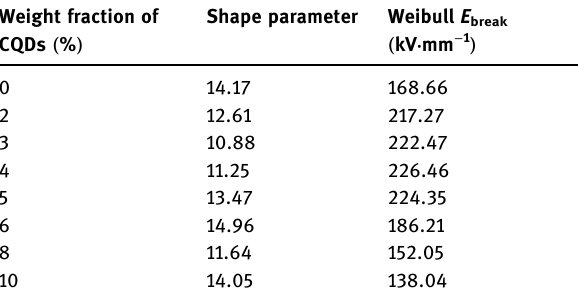
Table 1: Weibull analysis of breakdown strength Weight fraction of CQDs ( % )